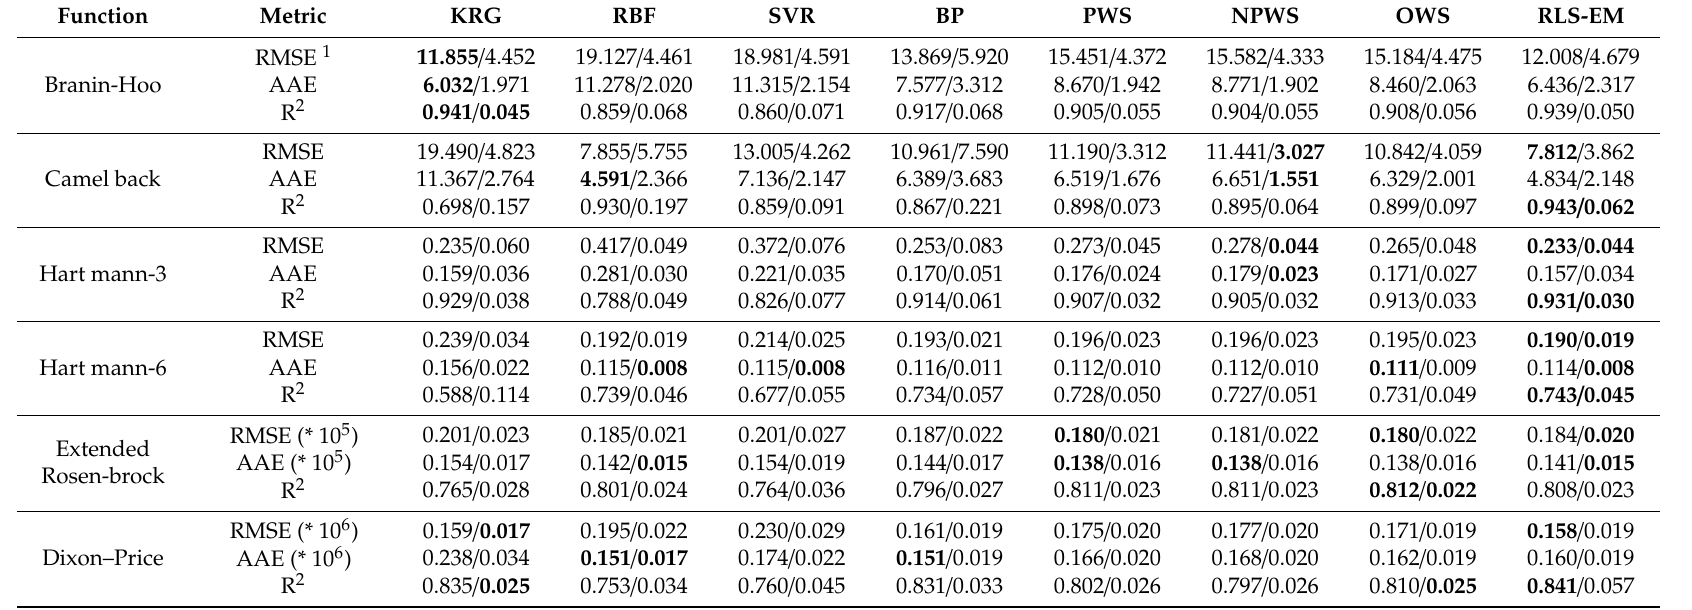
Table 3. Comparison of root mean squared error (RMSE), average absolute error (AAE), and R 2 for di ff erent surrogate models. BP: BestPRESS, PRESS: prediction sum of squares, PWS: PRESS weighted surrogate, NPWS: non-parametric PRESS weighted surrogate, OWS: optimal weighted surrogate, RLS-EM: regularized least squares ensemble